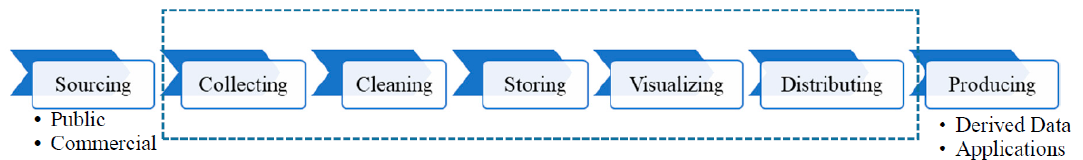
Figure 4. The process of data management.